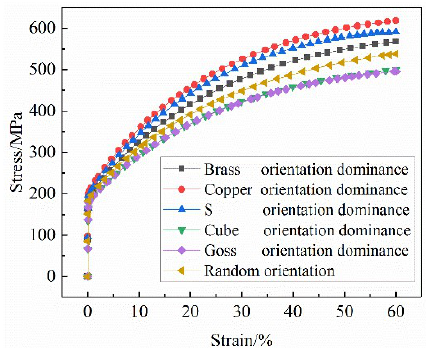
Figure 13. Comparison of stress and strain curves of RVE models with typical texture orientation.